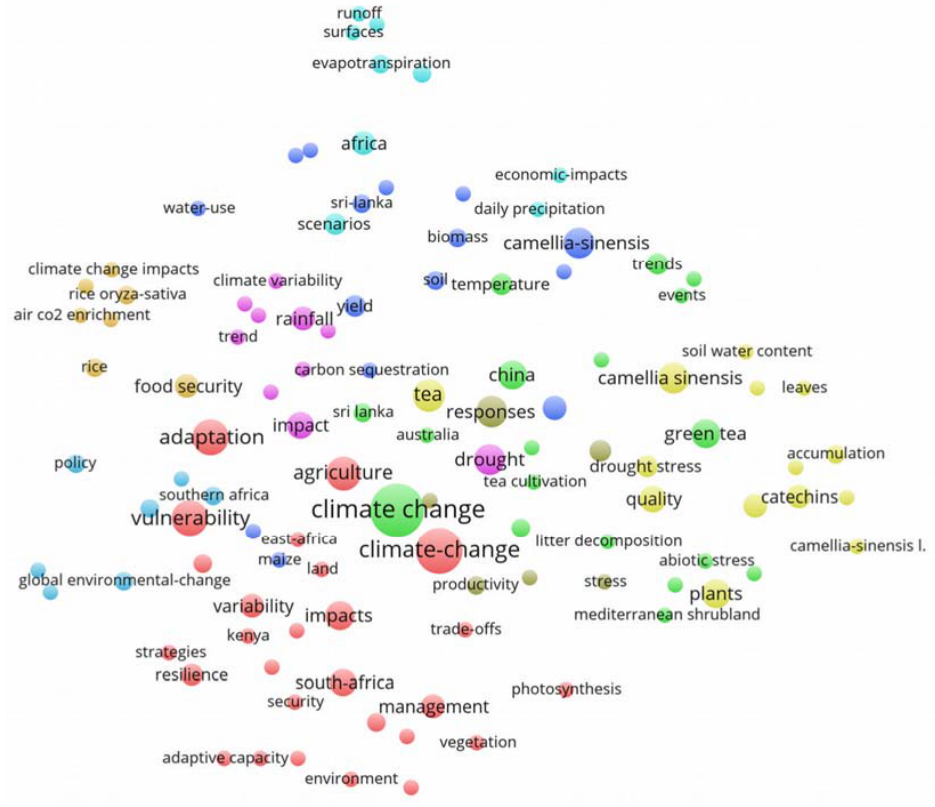
Figure 1. Co-occurrence network of keywords from 84 papers on climate change and tea production (the minimum number of papers containing a specific keyword is two).